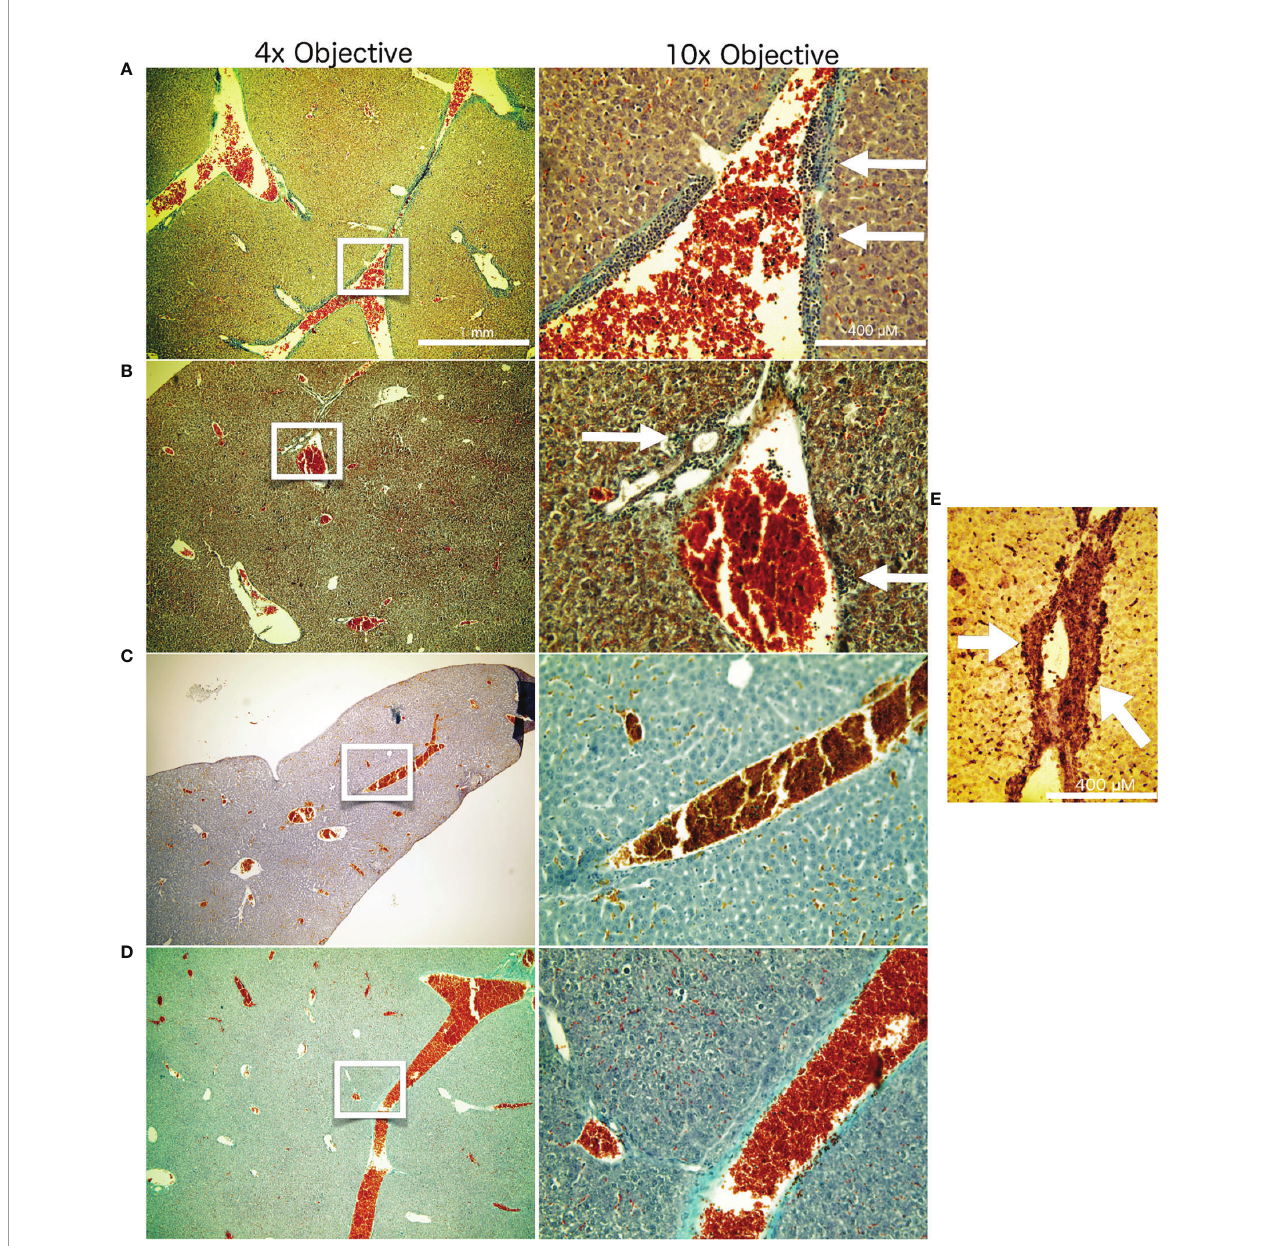
FIGURE 6 | Liver histology. Masson Goldner staining of liver tissue from the different treatment groups after termination of the experiment at day 26. The white frames on the left column of images indicate the image seen in higher magni fi cation in the right column. Represented are examples from the respective treatment groups: Untreated negative controls (A) . Mice which received 14 Gy of x-ray irradiation localized to the tumor at day 14 (B) . Mice which received Cabozantinib at 10 mg/kg per day beginning with day 5 after tumor inoculation (C) . Mice which received both 14 Gy irradiation to the tumor and the diet supplemented with Cabozantinib (D) . White arrows indicate the patches of CD11b-positive cells, indicating MDSC. (E) Representative CD11b staining of a liver sample from a untreated mouse 26 days after tumor inoculation. White arrows are pointing to the patches of CD11b-positive cells adjacent to liver